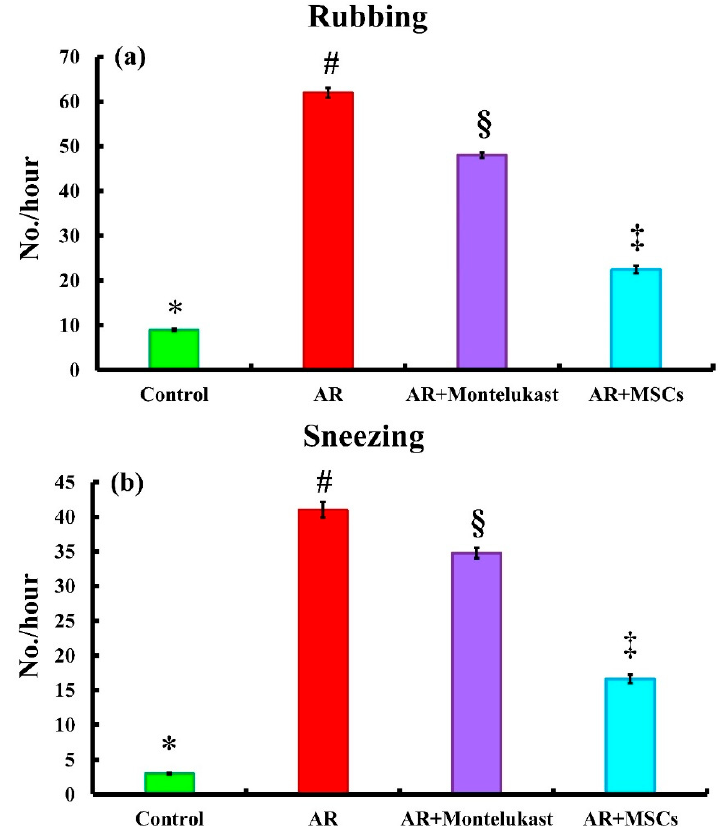
Figure 2. Systemic administration of MSCs reduced allergic symptoms. Rubbing ( a ) and sneezing ( b ) in different experimental groups. Different superscripts (*, #, §, and ‡) indicate significant differences among the experimental groups at p < 0.05. Data are shown as mean ± S.E.M, n = 6.